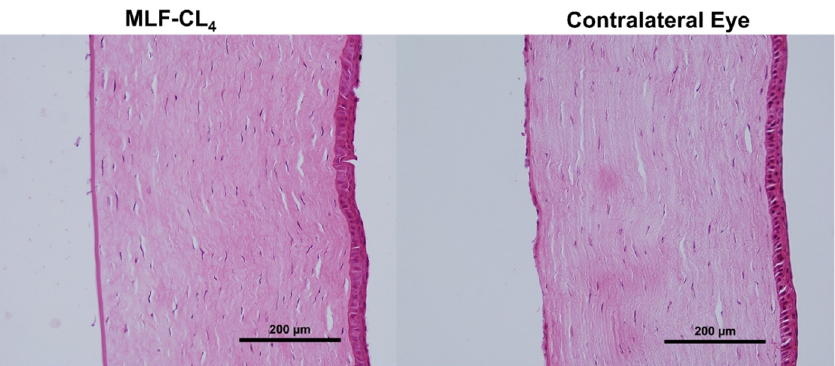
Figure 8. Hematoxylin and Eosin(H&E) stained corneas for New Zealand white rabbits (NZW) eyes wearing miltefosine-eluting contact lenses (MLF-CL 4 ) compared to the contralateral eye (untreated).